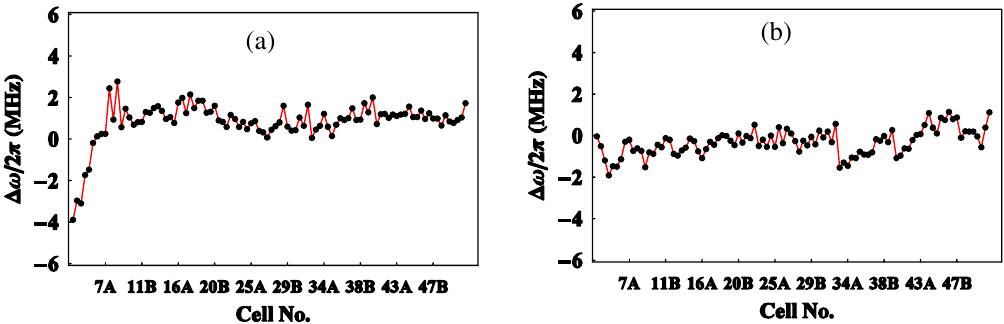
FIG. 8. (Color) Frequency deviations of the fundamental mode (a) and dipole mode (b) frequencies from their design values for all cells of H60VG4SL17A/B.